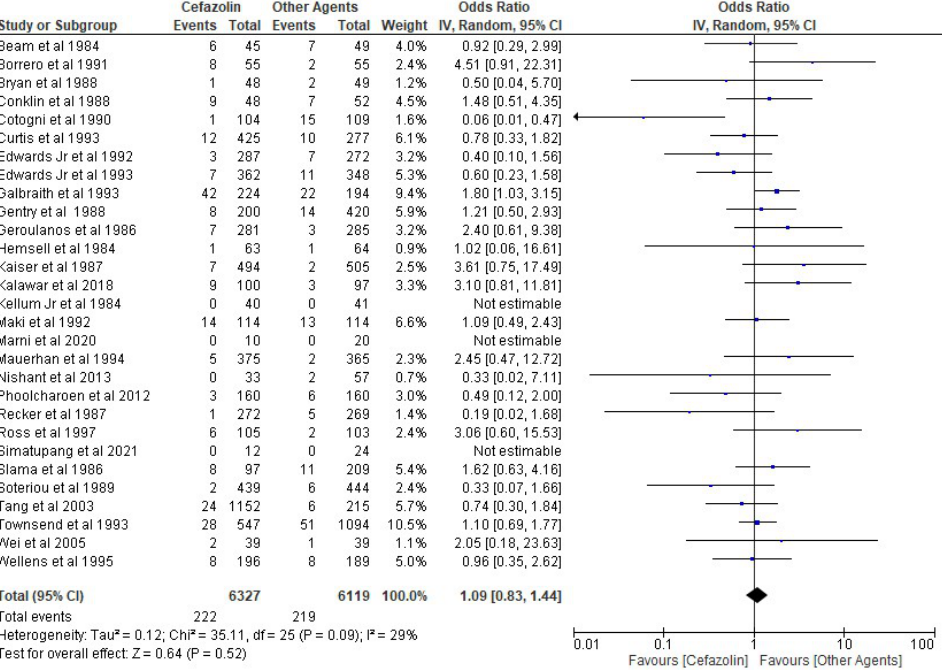
Figure 2. The rate of SSIs in the cefazolin group vs. other cephalosporins. The included studies